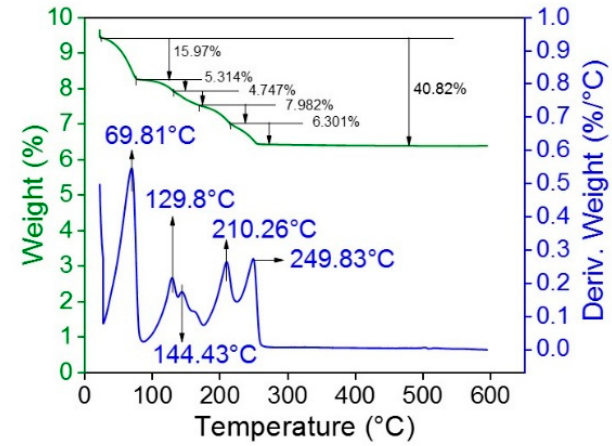
Figure 2. TGA measurements of powders synthesized at 80 °C representing the percentage of weight loss with its corresponding derivative.